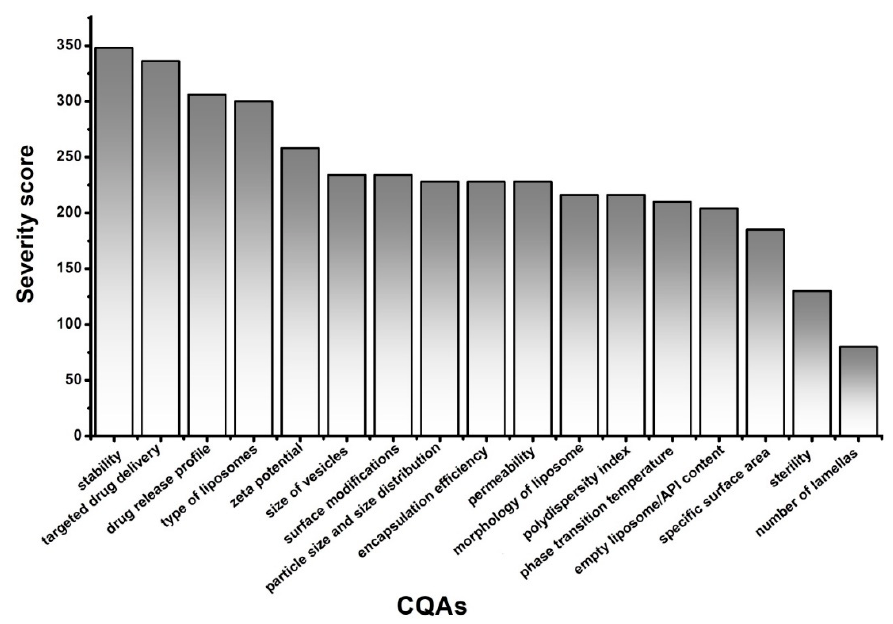
Figure 3. Rankings of the critical quality attributes (CQAs) of the liposomes.